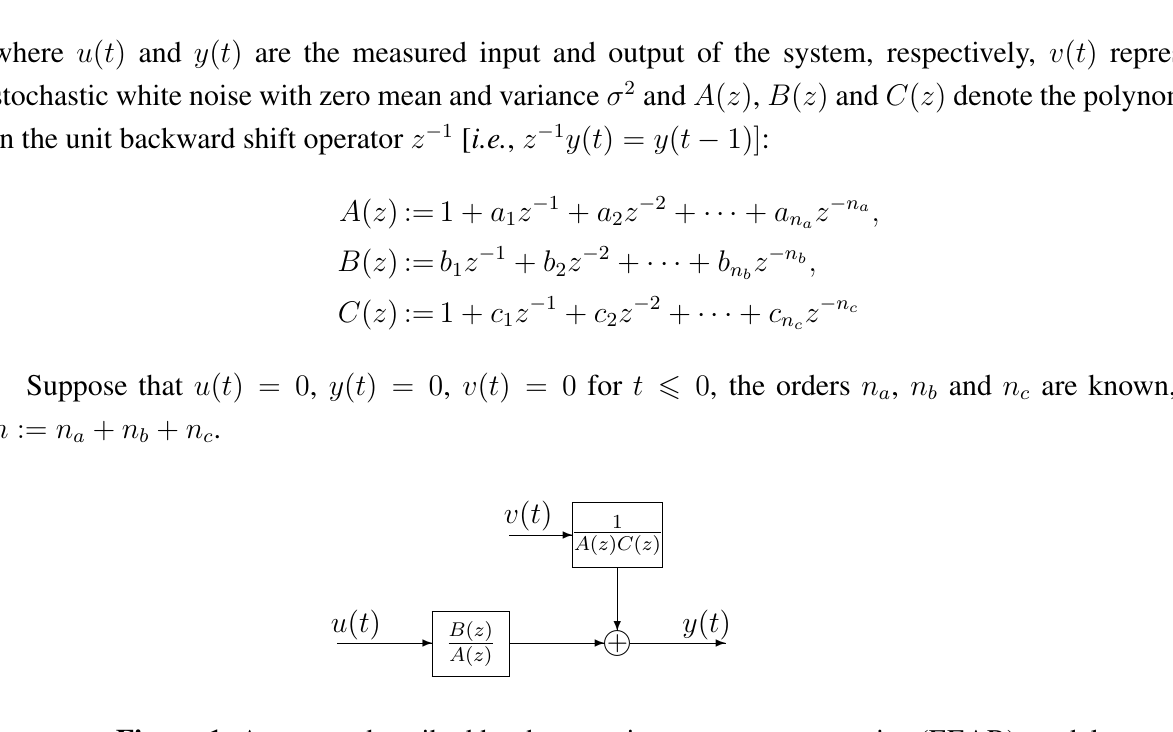
Figure 1. A system described by the equation-error autoregressive (EEAR)